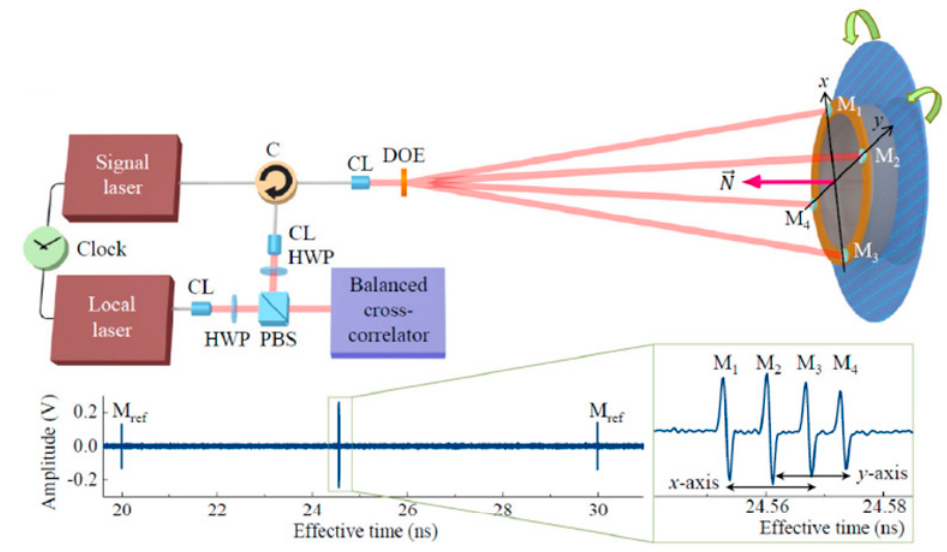
Figure 13. An example of the angle measurement based on the absolute distance measurement [63].